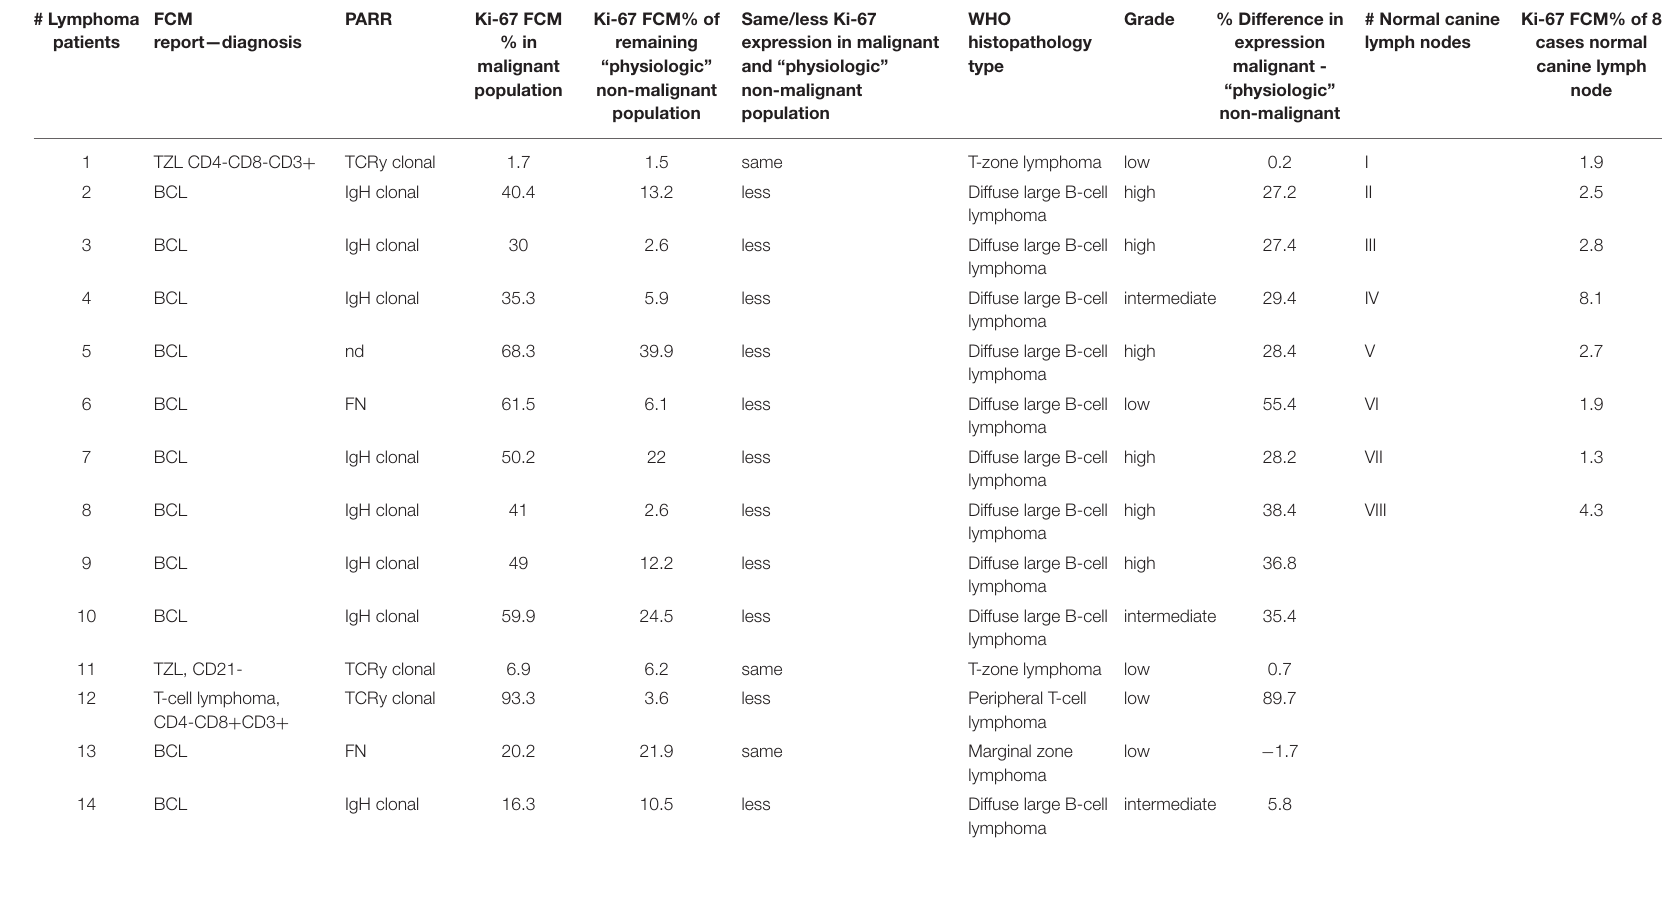
TABLE 4 | Case numbers consecutively used throughout the manuscript (#1 to #14) with FCM report – diagnosis, clonality testing result (PARR), Ki-67 FCM percent (%) in malignant population, Ki-67 FCM percent (%) of remaining “physiologic” non-malignant population, histopathological and IHC diagnosis, Ki-67 percent (%) difference in malignant and non-malignant population, case numbers consecutively used throughout the manuscript for 8 normal canine lymph node samples (#A to #H) and Ki-67 FCM percent (%) in these 8 cases. # Lymphoma